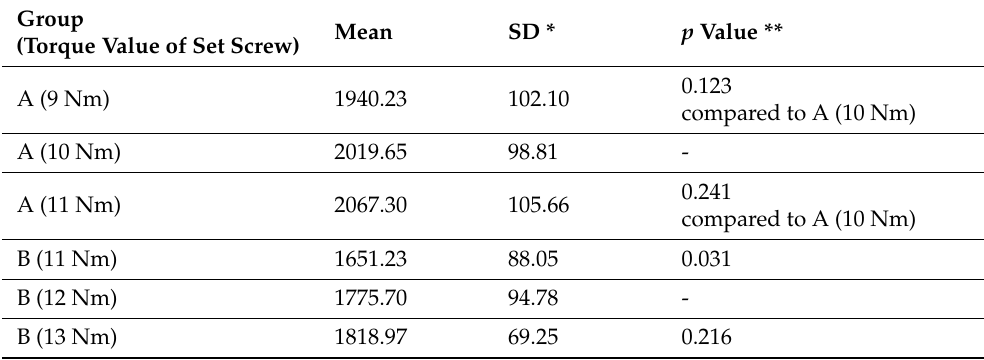
Table 2. Comparison of axial gripping capacity (AGC) between test groups.